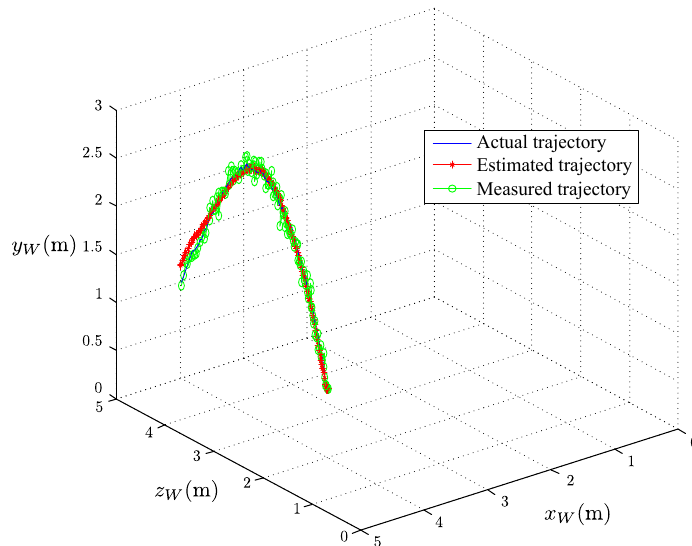
Figure 11. Comparison of the actual trajectory, estimated trajectory, and measured trajectory.